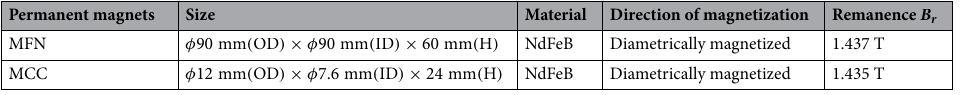
Table 4. Specifications of magnets used in the proposed MAC